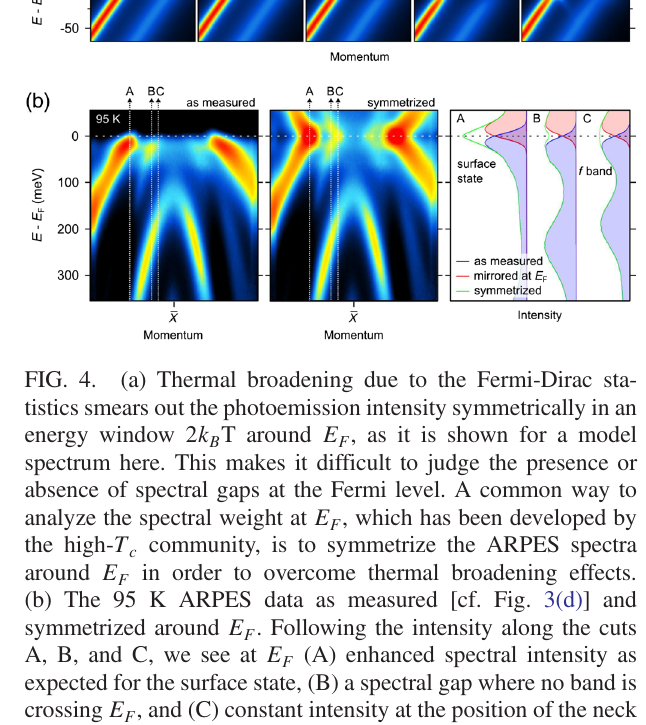
FIG. 3. Temperature-dependent FS evolution of YbRh 2 Si 2 . The T dependence is studied looking at two characteristic segments of the BZ that are schematically depicted in (a). (b),(c) “ Diagonal ” and (d) – (f) “ neck ” direction. The respective ARPES-derived energy-momentum maps are taken across the single-ion T K and the “ coherence ” T (cid:2) temperatures. Note that the data shown in (d) are taken at another instrument with a different exper- imental geometry, leading to different sensitivities for 4 f and valence states due to symmetry reasons. A detailed analysis of the spectral structure close to E F at 95 K is presented in Fig. 4.